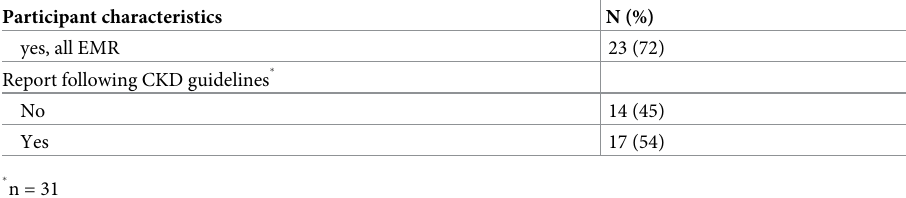
Table 2. PCP-reported comfort with managing CKD and access to clinical tools (n = 32).